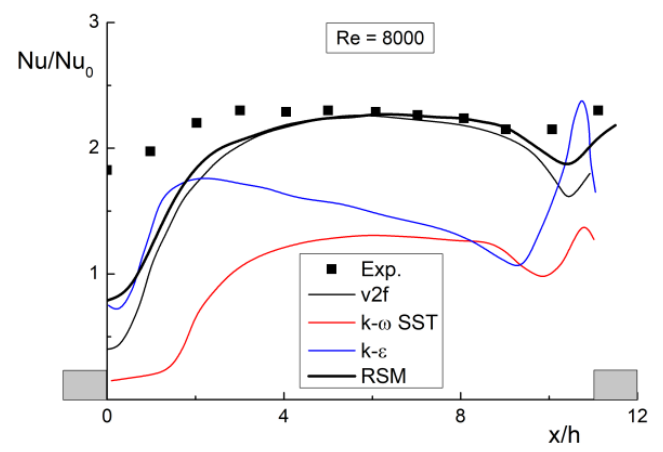
Figure 5. Distribution of heat transfer enhancement ratio in the flow around a two-dimensional square obstacle. Re D = 0.8 × 10 4 , h = e = 4 mm, p = 40 mm, H = 30 mm, H / h = 7.5, T 1 = 300 K, q W = 1 kW/m 2 , Tu 1 = 5%. The symbols are the experiments of [40]; the lines are predictions: v 2 f , k – ω SST, and k – ε are predictions of [41], and RSM is the authors’ simulations. Reprinted with permission from (Liu, J. et